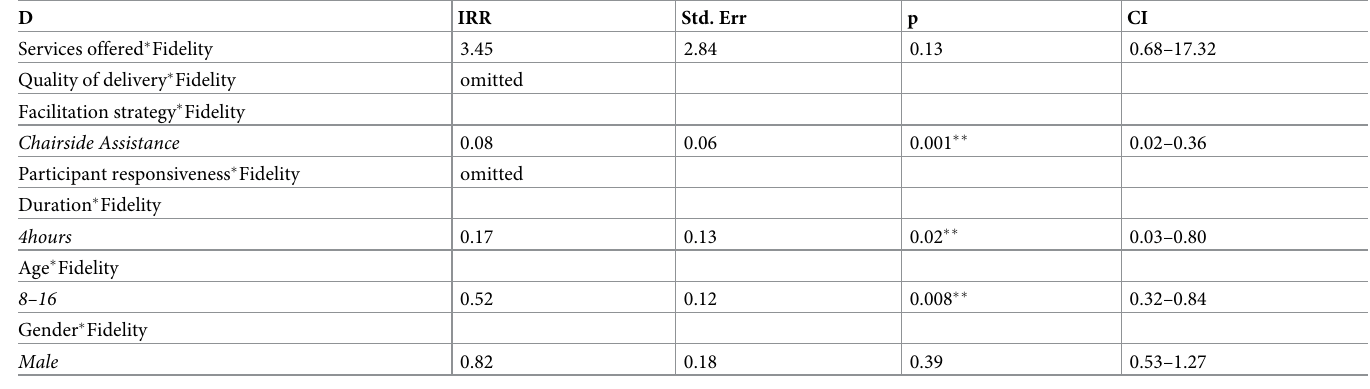
Table 3. Moderating effects of fidelity on dental